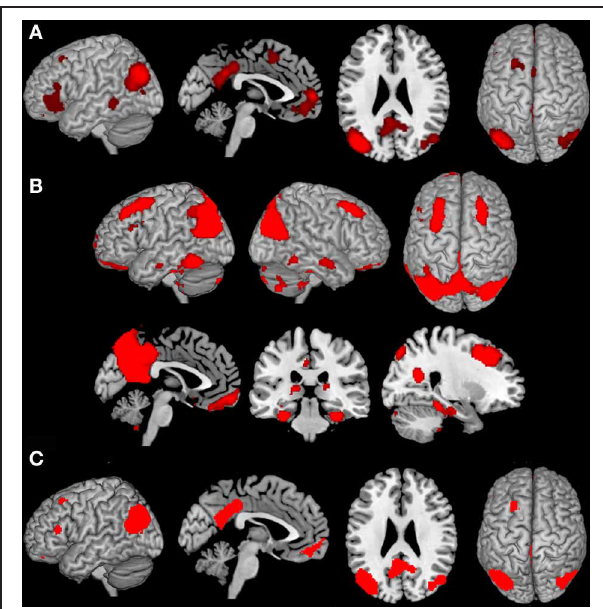
FIGURE 2 | Results of the task-dependent (A), task-independent (B) analysis as well as the conjunction across both approaches (C). (A) Task-dependent functional connectivity of the seed region with bilateral parietal cortex extending into middle temporal and middle occipital gyri, with posterior cingulate cortex and precuneus, medial orbitofrontal cortex, left inferior frontal gyrus, left middle/superior frontal gyrus and left middle temporal gyrus. (B) Task-independent functional connectivity of the seed with bilateral parietal cortex extending into lateral occipital und temporal gyrus, precuneus and posterior cingulate cortex, as well as with bilateral cerebellum, hippocampus, parahippocampal gyrus, thalamus, fusiform gyrus, inferior and middle temporal gyrus, middle frontal gyrus, left inferior frontal gyrus, and medial orbitofrontal cortex. (C) Conjunction of task-dependent and task-independent connectivity reveals significant functional connectivity of the seed area with bilateral inferior parietal cortex, precuneus and posterior cingulate cortex, left middle and inferior frontal gyrus and medial orbitofrontal cortex.